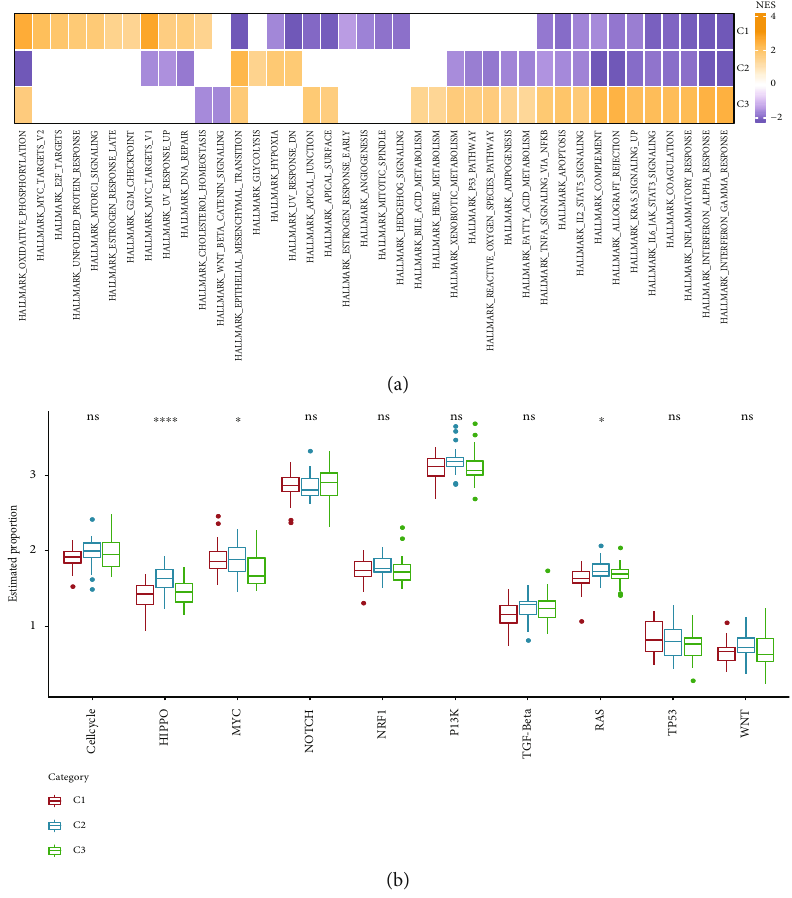
Figure 3: Gene Set Enrichment Analysis for osteosarcoma in the TCGA cohort. (a) Comparison of enriched pathways among the three molecular subtypes. (b) The estimated proportion of 10 oncogenic pathways among three molecular